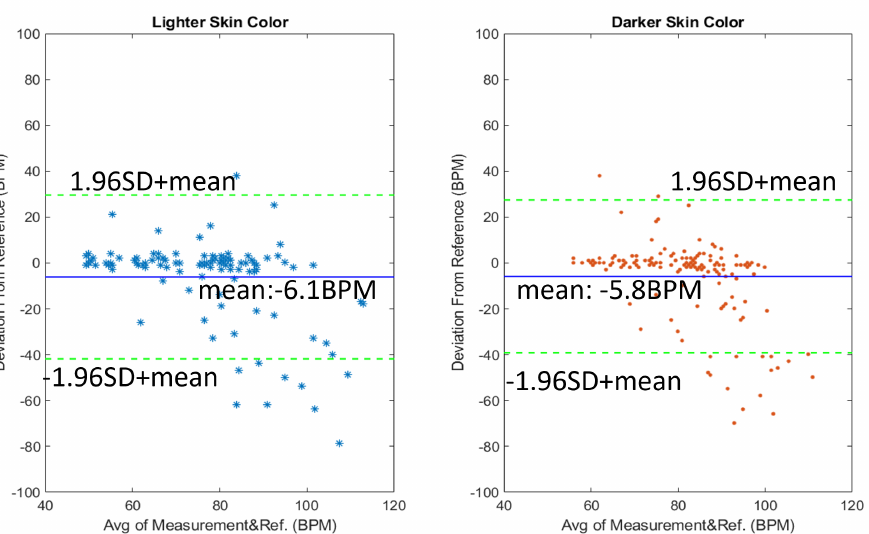
Figure 15. Bland–Altman plot for HR measurements within groups of: lighter skin color ( left ) and darker skin color ( right ).